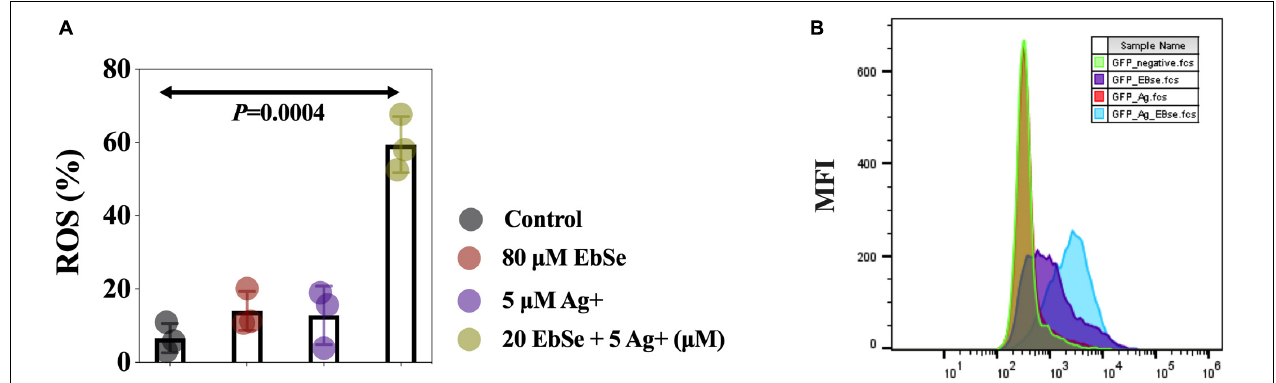
FIGURE 6 | EbSe-Ag + upregulates ROS production in YpIII. YpIII-mCherry was cultured to A 600 of 0.4 and treated with EbSe-Ag + . (A) Cells were stained with 5 µ M CellROX TM Deep Red Reagent for 30 min at 37 ◦ C and detected by FCM; (B) quantitative values.